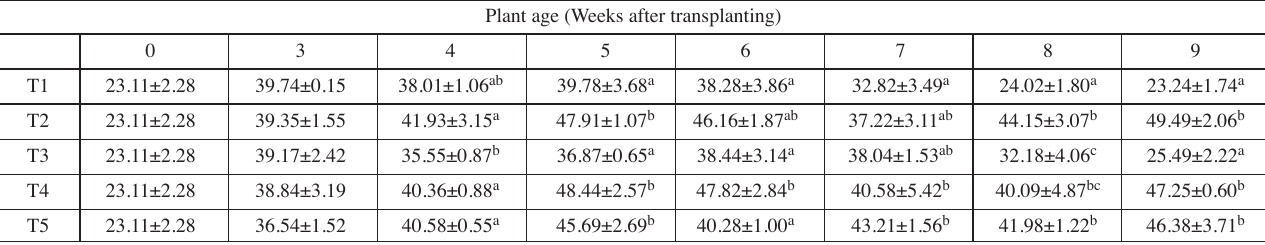
Tab. 8: Effect of organic and inorganic fertilisers chlorophyll content (SPAD units) of Solanum nigrum L. leaves cultivated in the greenhouse.